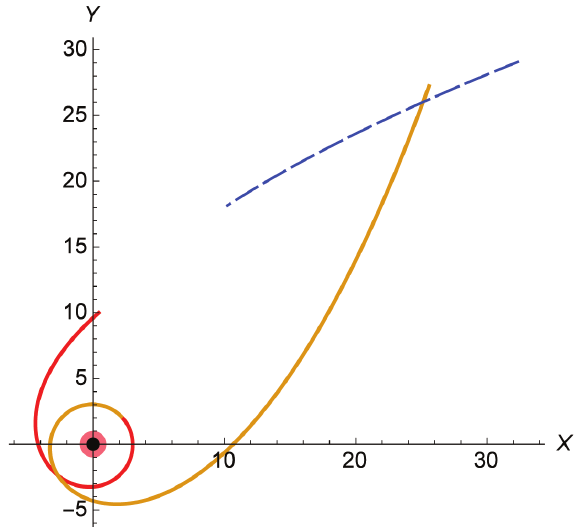
Figure 12. Overfly trajectory near retrograde-rotating black hole for initial conditions a = − 0.5 and √ j = 1 + 2 + 10 − 3 . These parameters were selected to reveal clearly on the graph the impact of the black hole rotation on the trajectory of the traveling test body. The dashed line sketches the initial parabolic part of the test body trajectory, as the body approaches the retrograde-spinning black